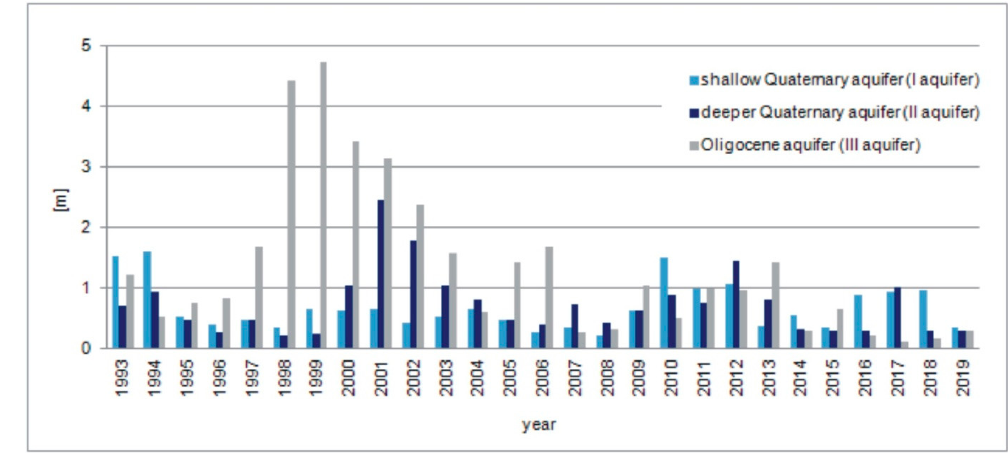
Figure 7. Annual amplitudes of the water table in Quaternary and Oligocene aquifers.